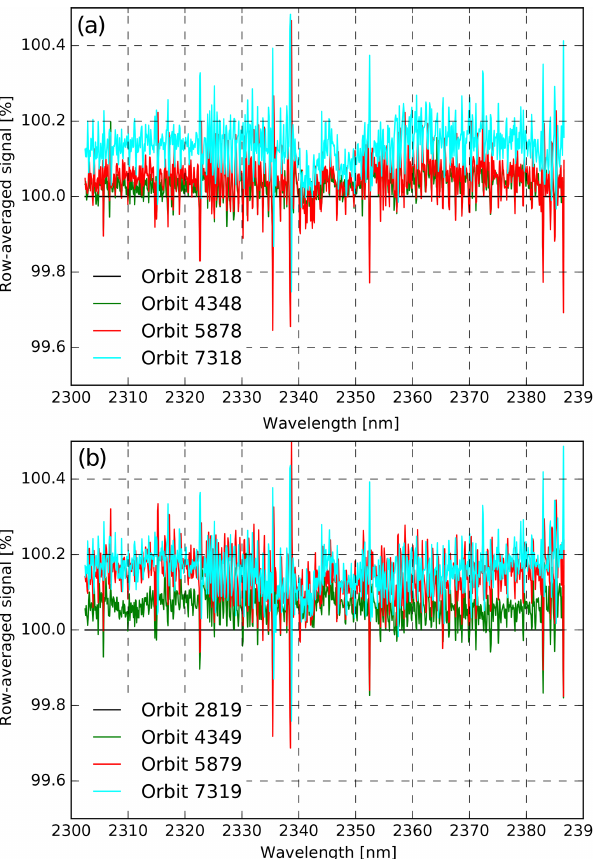
Figure 15. Row-averaged irradiance signal of the NIR detector via QVD1 for orbits 2818 (flat black line), 4348 (green), 5878 (red) and 7318 (cyan). Plot (a) is without degradation correction and shows much less degradation than in the UV and UVIS spectral ranges. Plot (b) shows the corrected signal where the degradation CKD used only the measurements up to and including orbit 5878. The latest orbit in the plot (cyan) is corrected using extrapolation in the L1b processor.